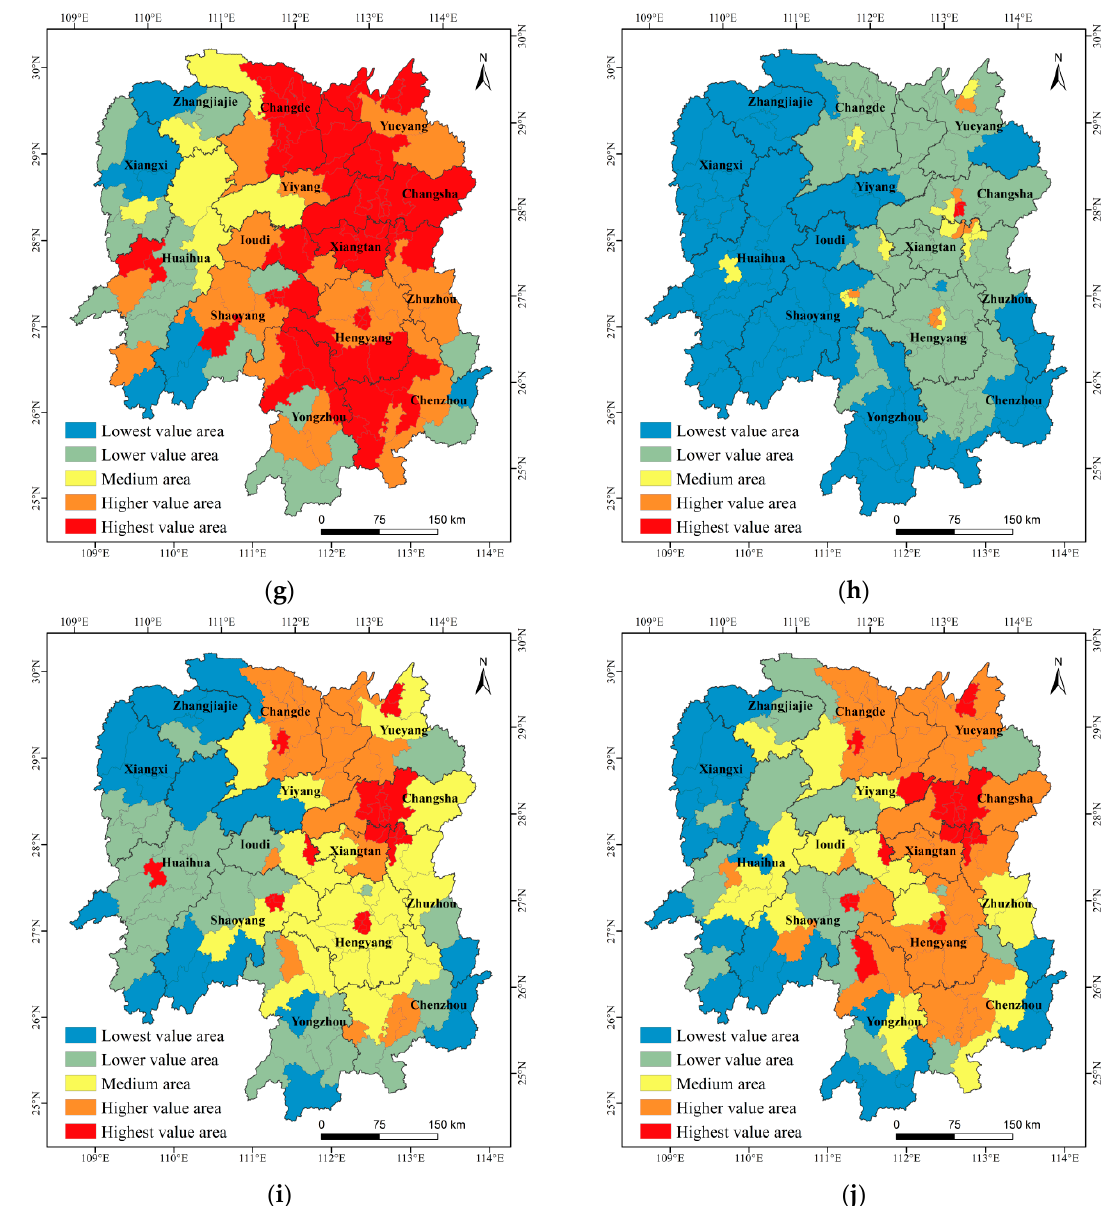
Figure 4. ( a ) Distribution of NPCs in Hunan Province in 2014, ( b – j ) are the inversion results of the SDG 1 evaluation values of Model I, Model Ⅱ , Model Ⅲ , Model Ⅳ , Model Ⅴ , Model Ⅵ , Model Ⅶ , Model Ⅷ , Model Ⅸ , respectively.